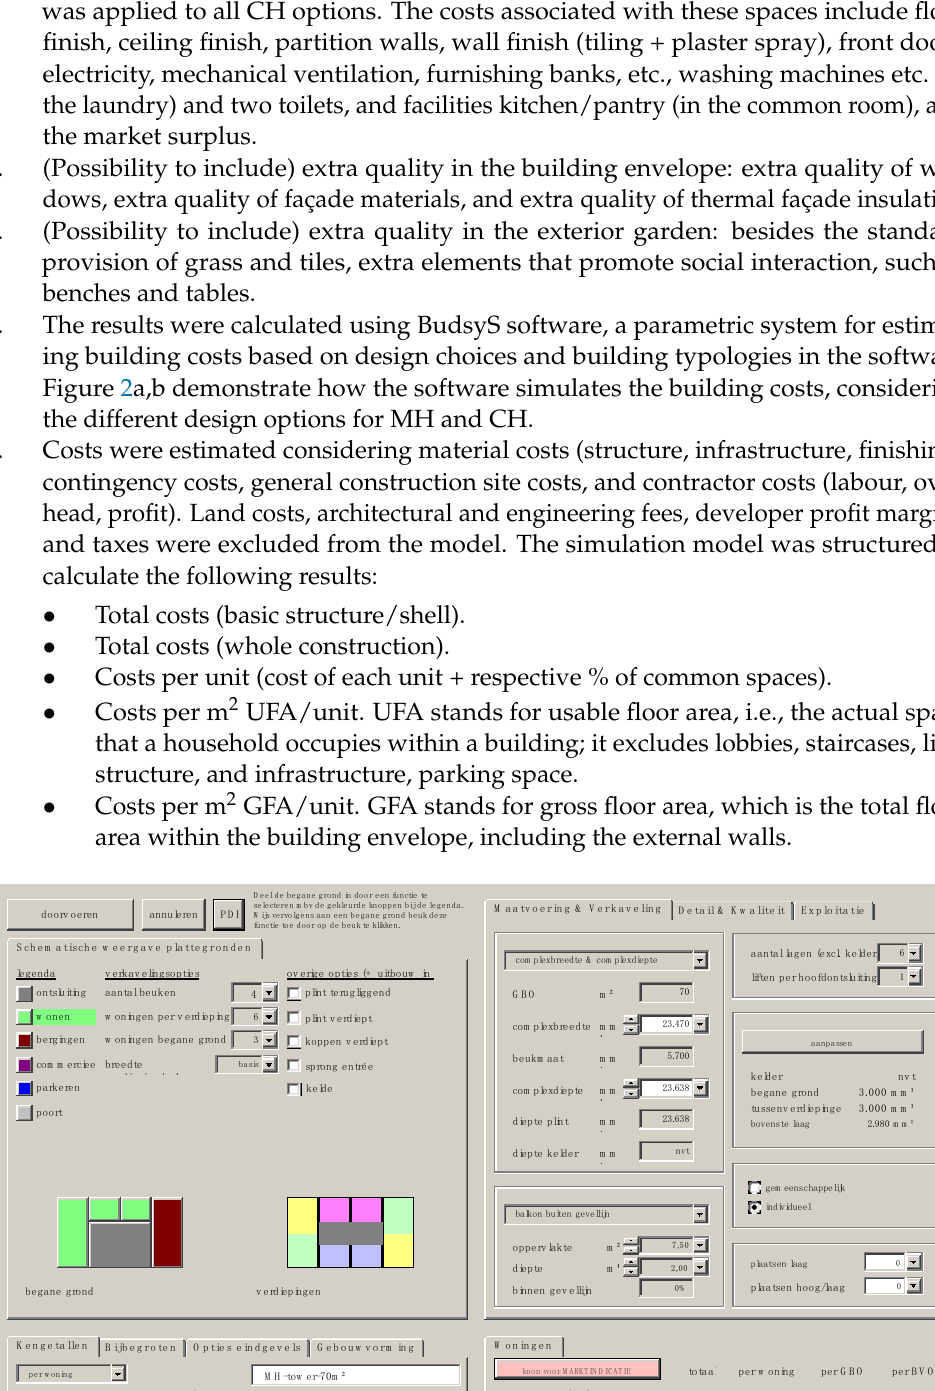
( b ) Figure 2. ( a , b ) Snapshots of the design specifications and resulting building costs for AT-MH and AT-CH, respectively. 4. Results: Comparing MH and CH Building Costs from a Design Perspective This section presents the results of the conducted simulation to compare the building costs of CH and MH based on design decisions. Table 2 displays a simpli fi ed version of the results (see Appendix B at the end of the paper for the complete table). From this simulation exercise we derive the following insights: 1.